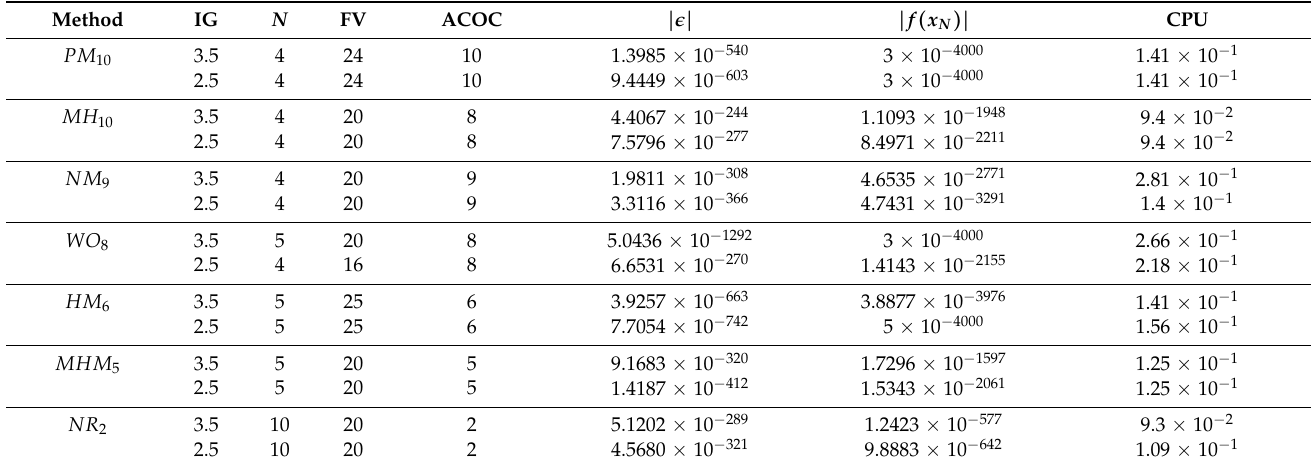
Table 5. Numerical results for problem 2: g 3 ( x ) .